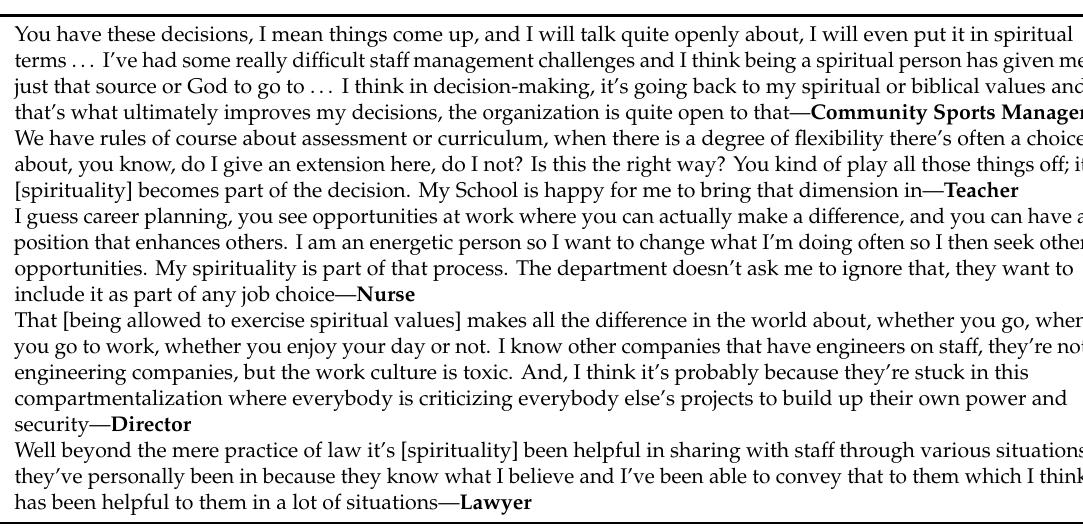
Table 2. Extracts in support of Condition 1— Open Culture to Spirituality .